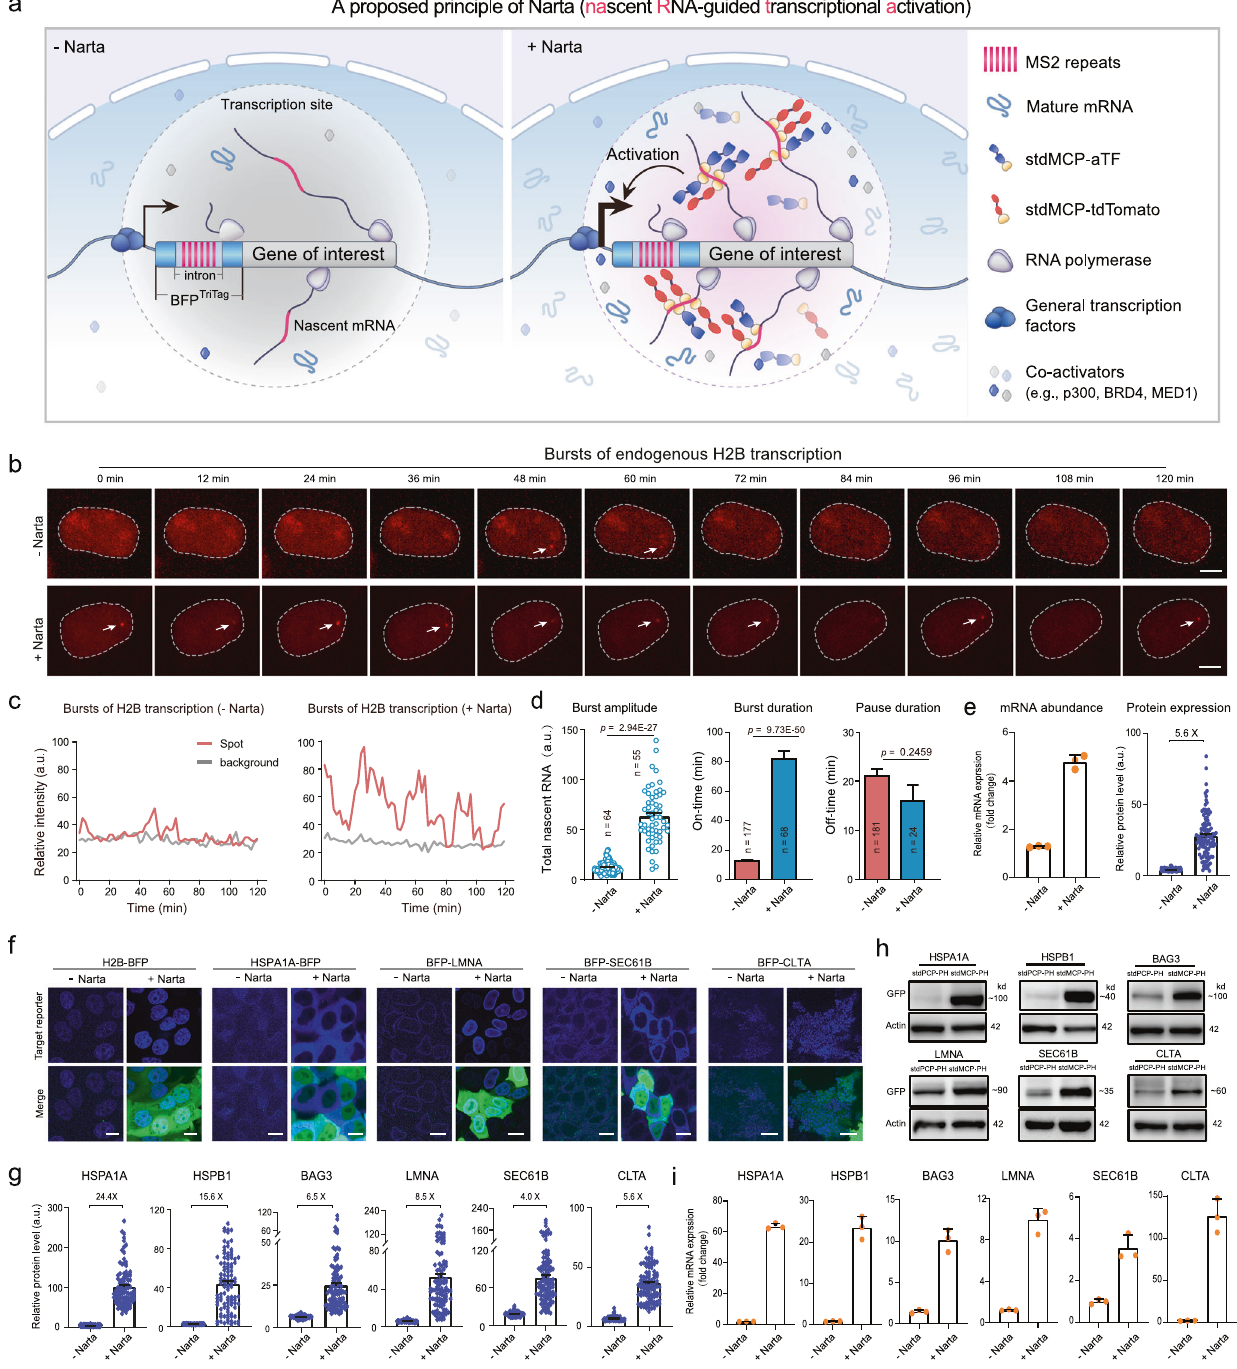
Fig. 1 | Narta activates endogenous genes. a Schematic depicting recruitment of arti fi cialtranscription factors(aTFs) or fl uorescent reporterstonascent mRNAsby the MS2/MCP system. b Snapshots of representative HeLa cells showing the tran- scriptional bursting dynamics of H2B loci revealed by stdMCP-tdTomato without (top) or with (bottom) Narta activation. Scale bar, 5 μ m. c Representative traces (red) of nascent transcripts produced at H2B loci from the cells in b . Gray traces illustrate the background signal in the nuclei. d Quantitative analysis of the burst amplitude (left), burst durations (middle) and pause durations (right) to show the bursting characteristics of H2B transcription. Burst amplitude is de fi ned by the total intensity of individual stdMCP-tdTomato spots. P values were calculated by two-tailed Student ’ s t test. e Quanti fi cations of H2B-BFP transcription by qRT-PCR ( n =3 biological repeats) and protein expression ( n =100 cells) by fl uorescent